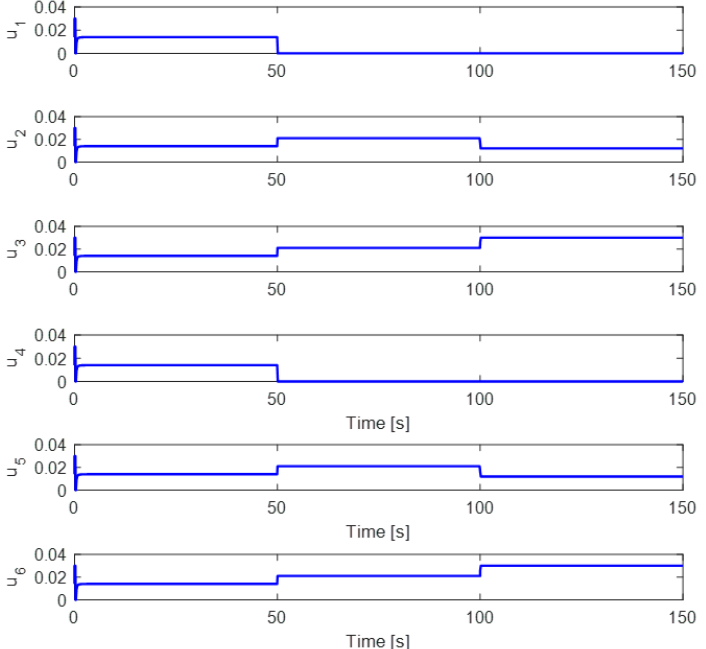
Figure 7. Response of motor’s command with complete fault in actuator 1 and partial fault in actuator 2.